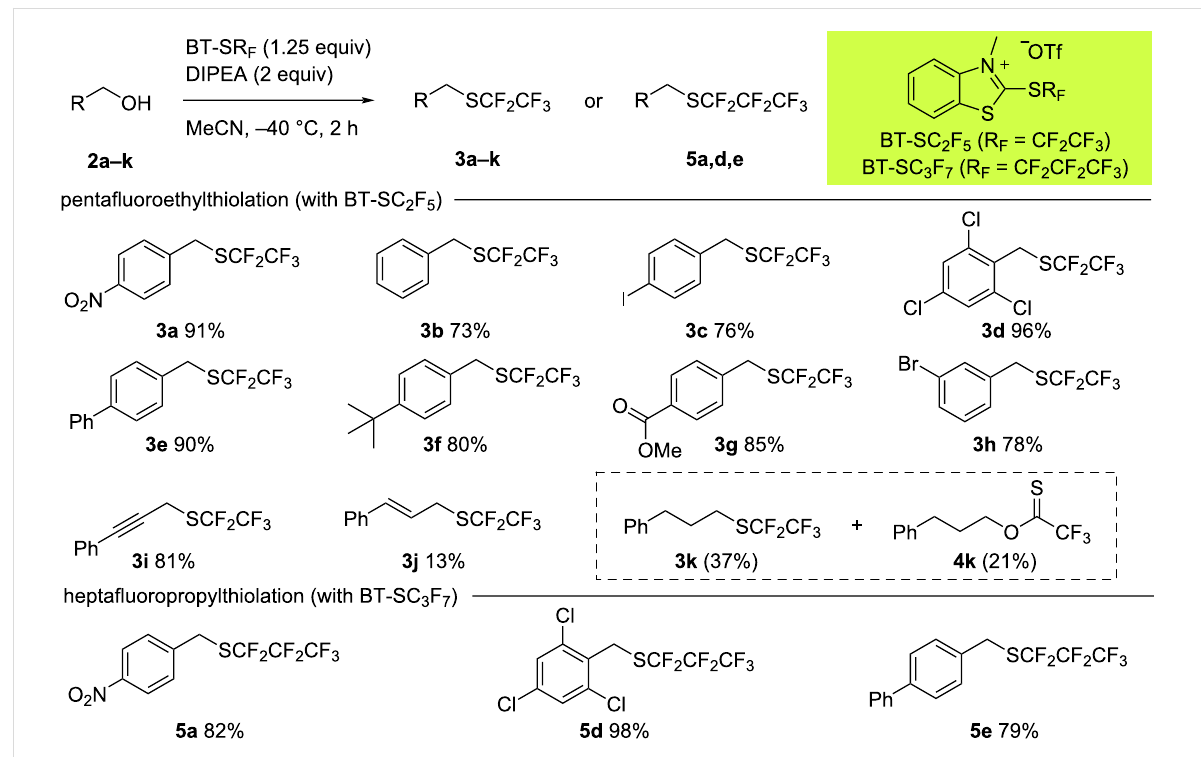
Scheme 4: Scope of the deoxygenative perfluoroalkylthiolation reaction using BT-SC 2 F 5 and BT-SC 3 F 7 .